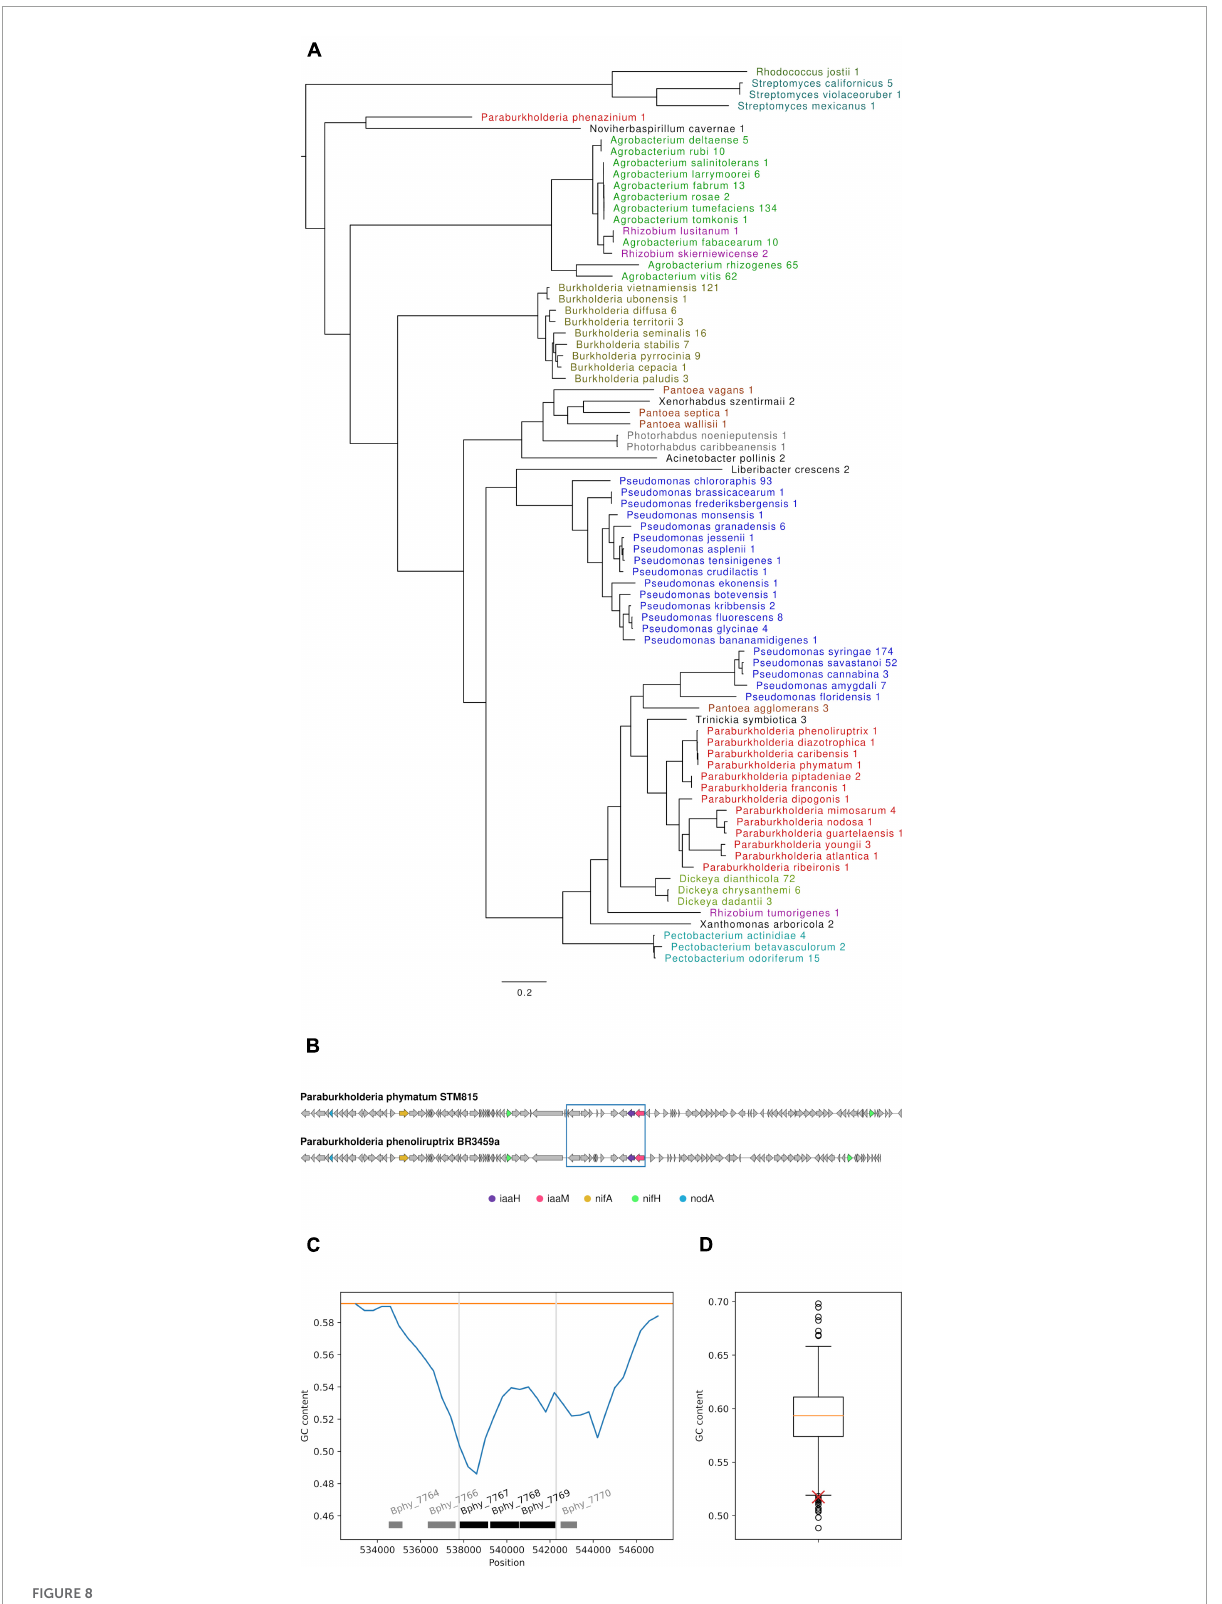
FIGURE8 In silico analysis of Paraburkholderia phymatum iaaMH genes. (A) Maximum likelihood phylogenetic tree of co-occuring orthologs of IaaH and IaaM in other species identified by cblaster. The numbers indicate how many strains per species were found. When more than one strain was